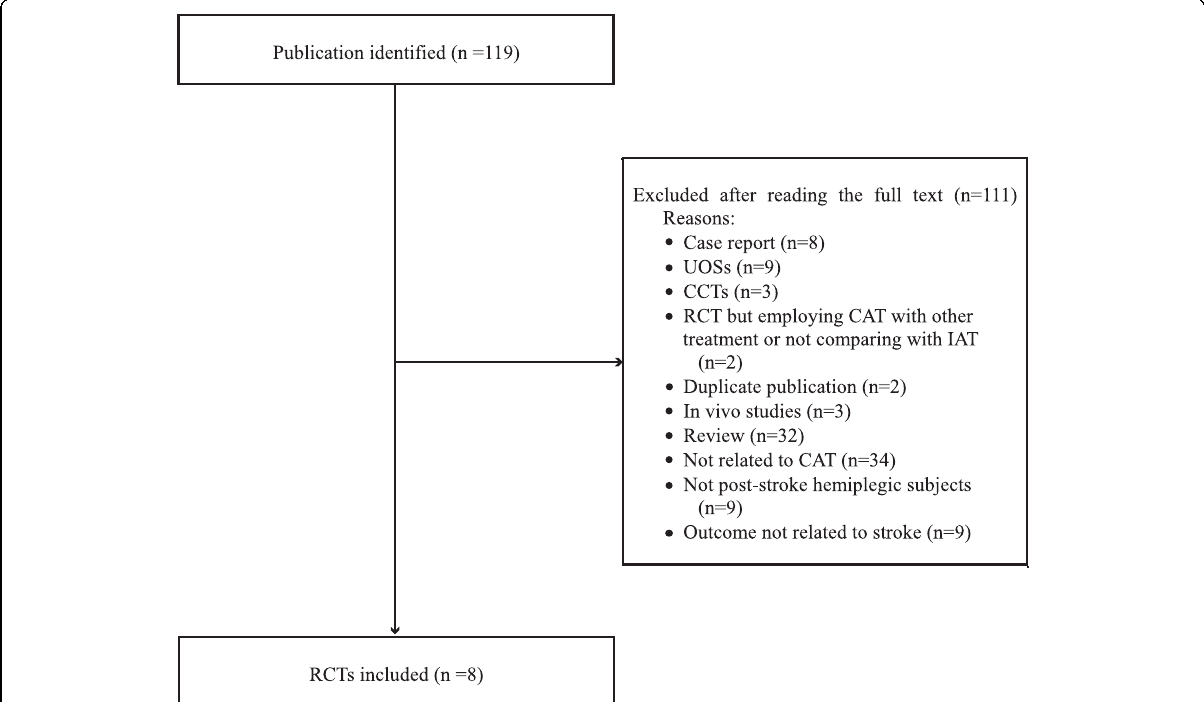
Figure 1 Flow chart of the study selection process . UOS: uncontrolled observational study; CCT: controlled clinical trial; RCT: randomized clinical trial; CAT: contralateral acupuncture; IAT: ipsilateral